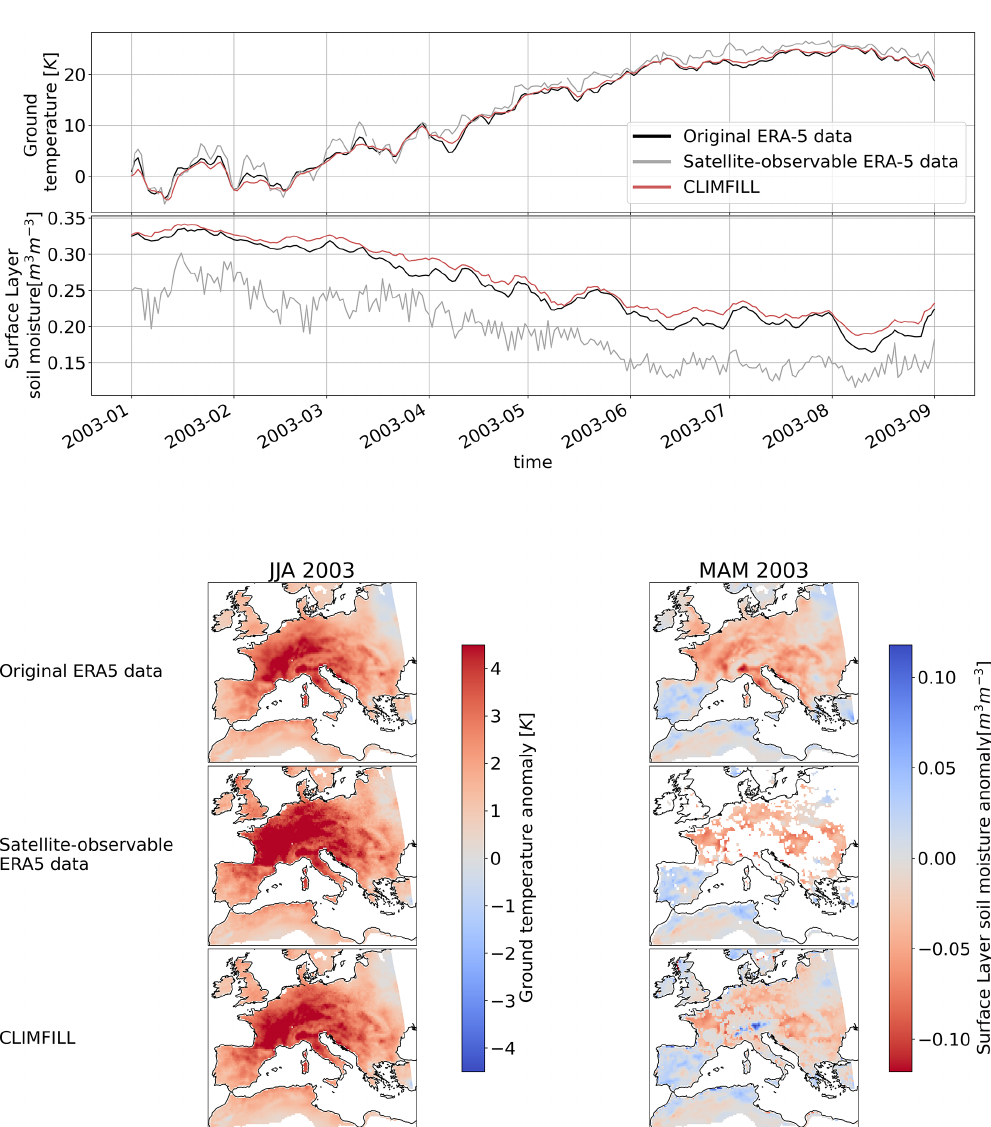
Figure 13. Development of ground temperature and surface-layer soil moisture over central Europe from January to August 2003, depicting the European heatwave 2003 for ERA-5 original data, satellite-observable ERA-5-data and CLIMFILL gap fill. The maps show anomalies of ground temperature for the three cases in JJA 2003 and anomalies in surface-layer soil moisture in the 3 preceding months (MAM 2003) over